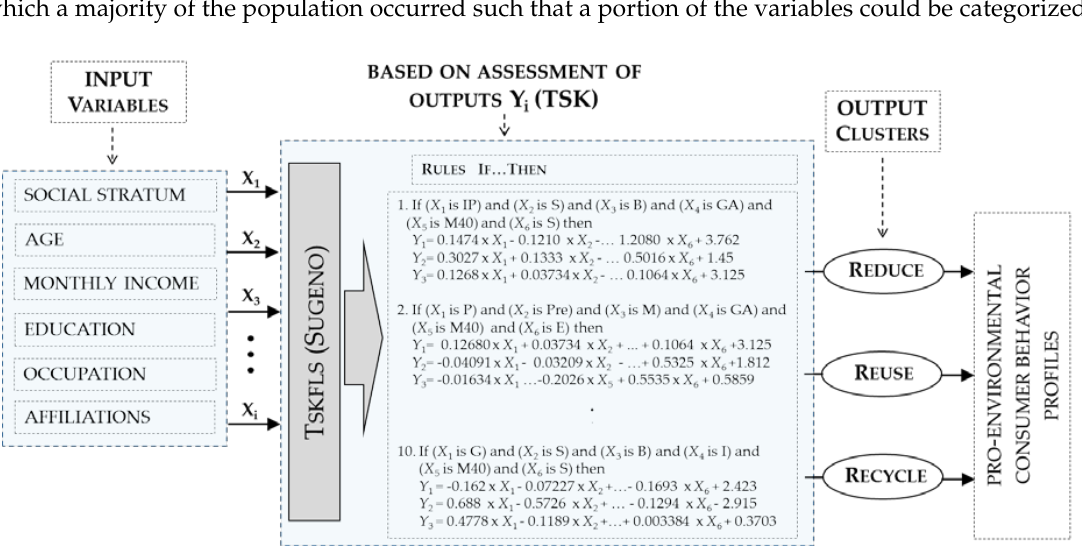
Figure 2. Fuzzy model architecture to evaluate consumer pro-environmental behavior.